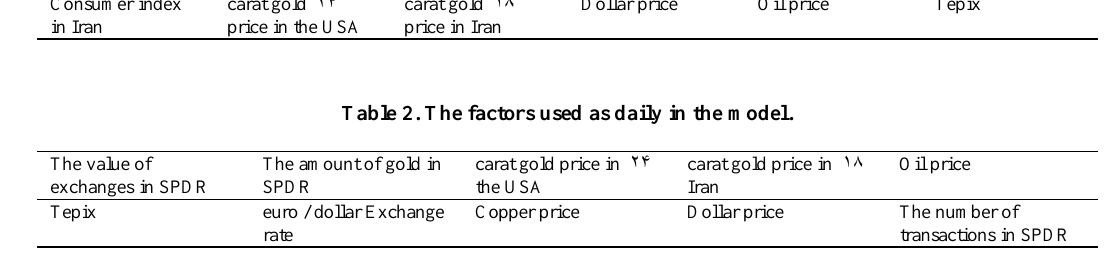
Table 3. The factors used as monthly in the model.